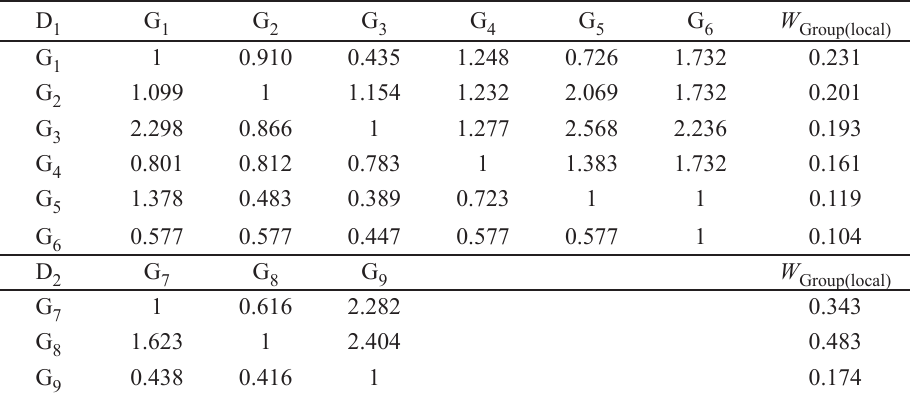
Table 3. Pair-wise comparison matrix and weights under each assessment